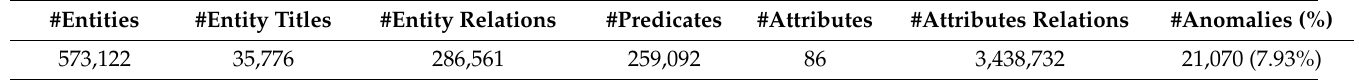
Table 2. Results of knowledge graph alignment with the full dataset with 5